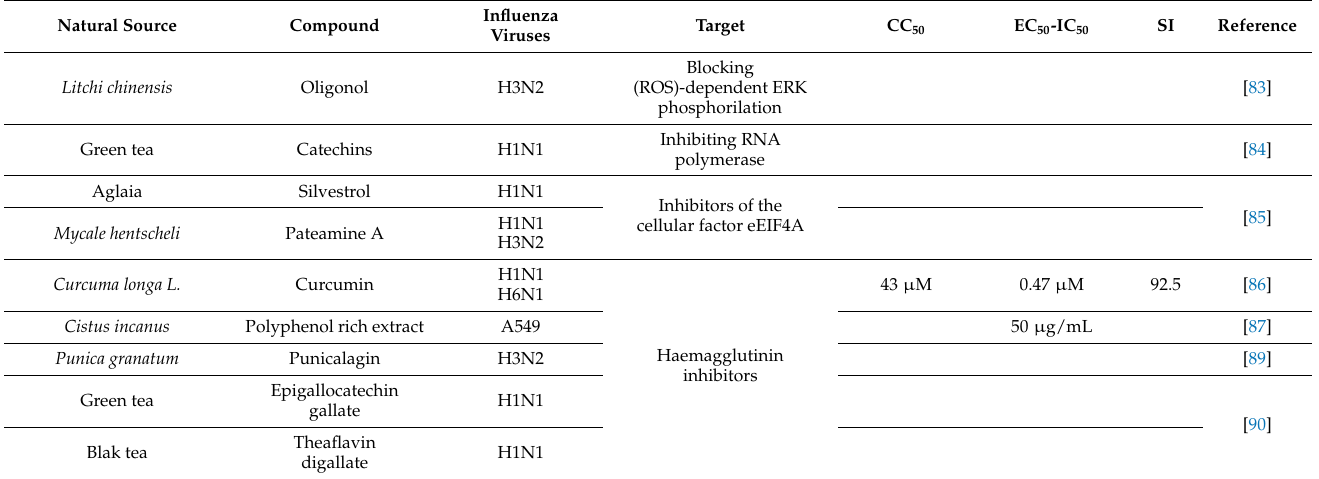
Table 6. Natural products against Influenza